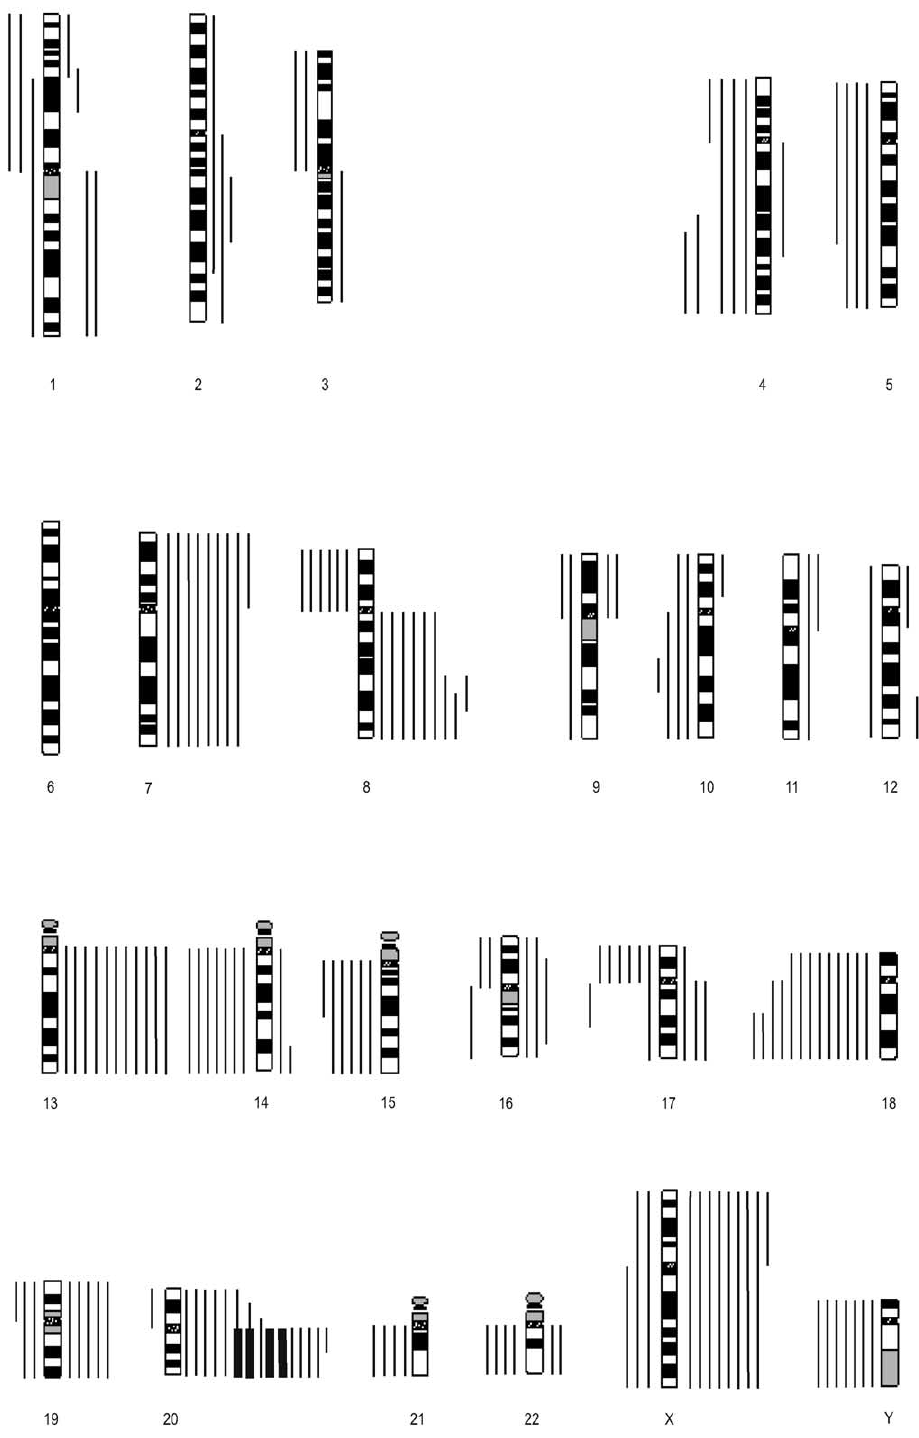
Fig. 1. Karyogram of chromosomal gains and losses in 18 colorectal carcinomas without liver metastases (group